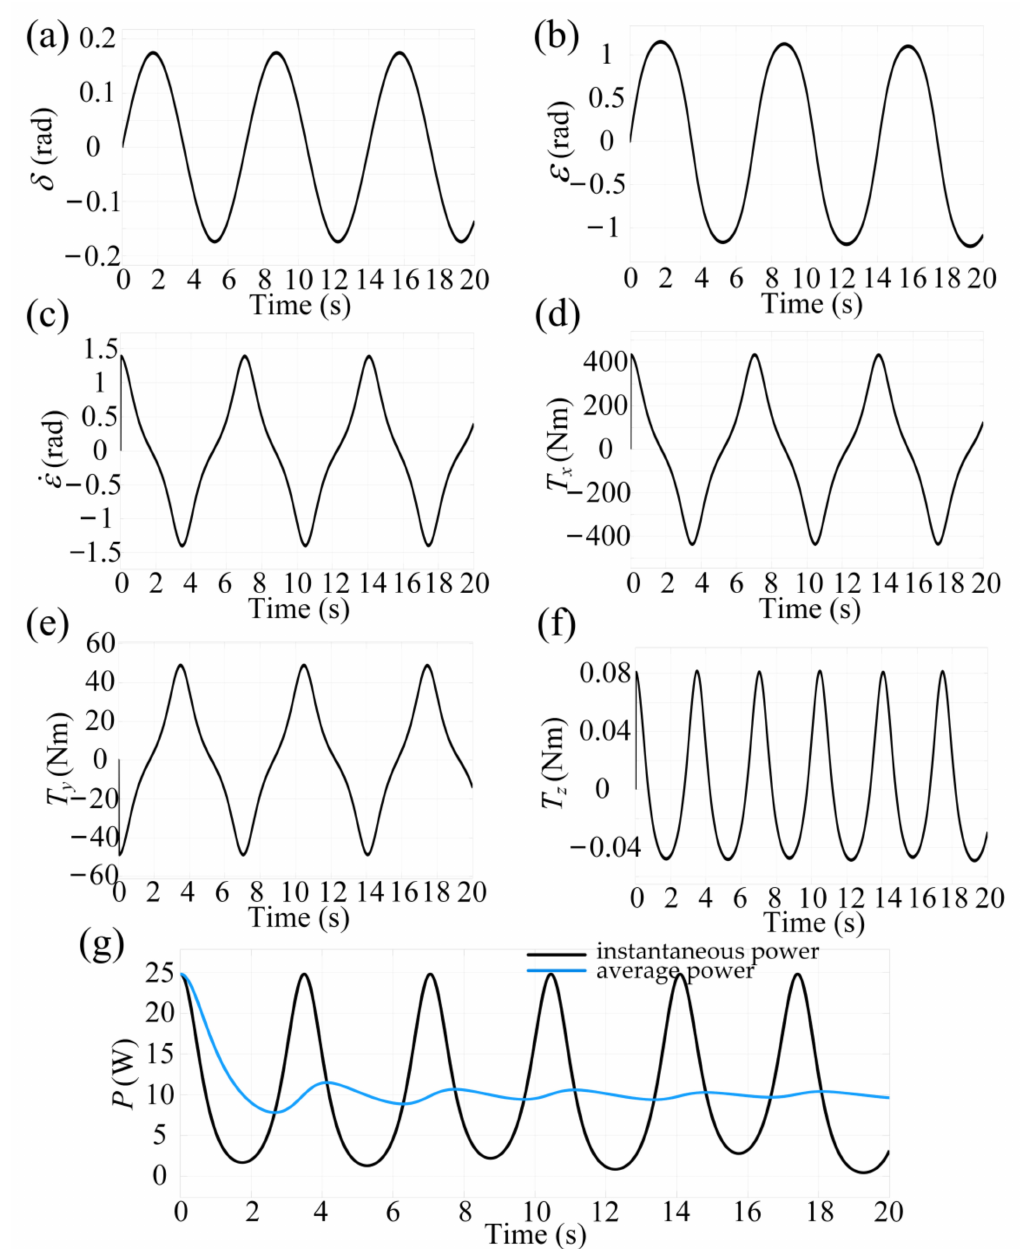
Figure 6. Performance of main parameters under rated conditions: ( a ) pitch amplitude; ( b ) flywheel precession angular displacement; ( c ) flywheel precession angular velocity; ( d ) torque in x direction; ( e ) torque in y direction; ( f ) torque in z direction; ( g ) output power (blue line is the average power, black line is the instantaneous